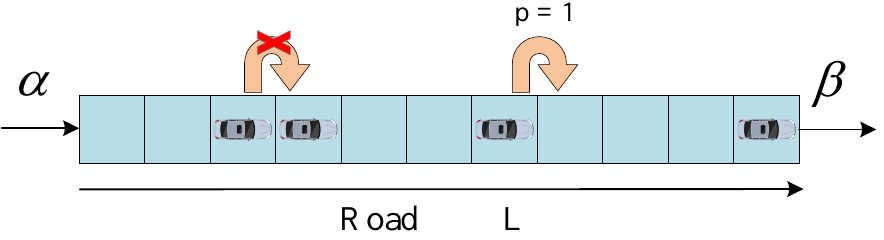
Figure 4. The totally asymmetric simple exclusion process (TASEP) model of traffic flow on road. System may be in the following three different stationary phases when α, β take different values. different